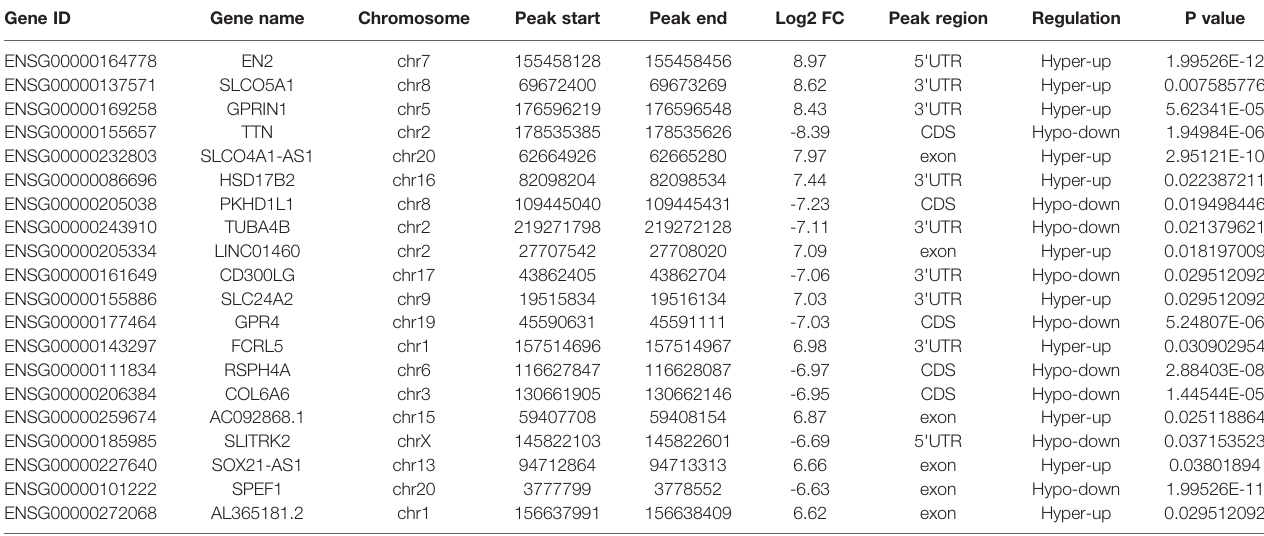
TABLE 3 | Top 20 differently genes in m6A-seq&RNA-seq&TCGA